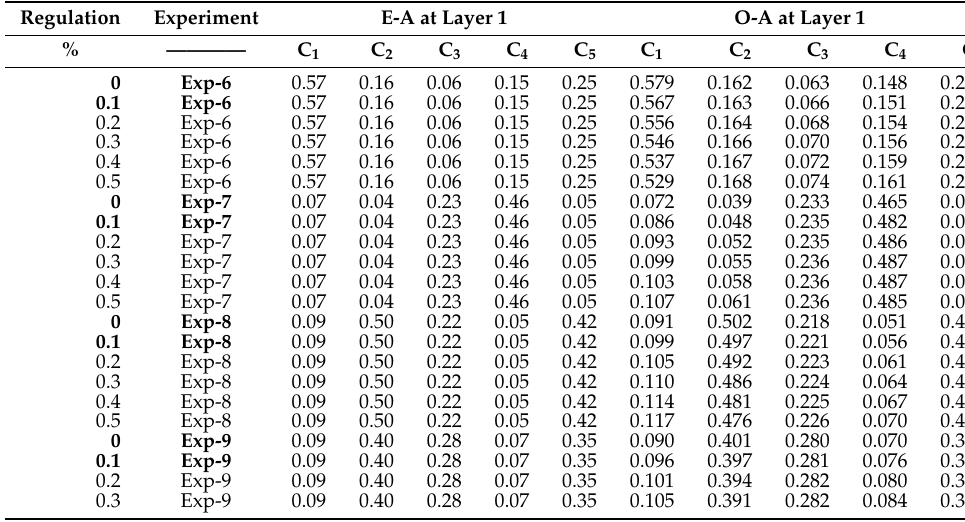
Figure 9. The trajectories of activation observed at input layer 0 while carrying out one thousand iterations of the GBP algorithm. The red circle is the starting point of trajectory, and the black circle is the activation value after the thousandth iteration. The graphs also depict the trajectories observed at input layer 0 with six regulation factors ρ (0%, 0.1%, 0.2%, 0.3%, 0.4%, and 0.5%). Each graph visualizes the recalled activation for five multiple-cue recall (MCR) experiments. Table 2. Observations of activations at abstract concept layer 1 for MCR